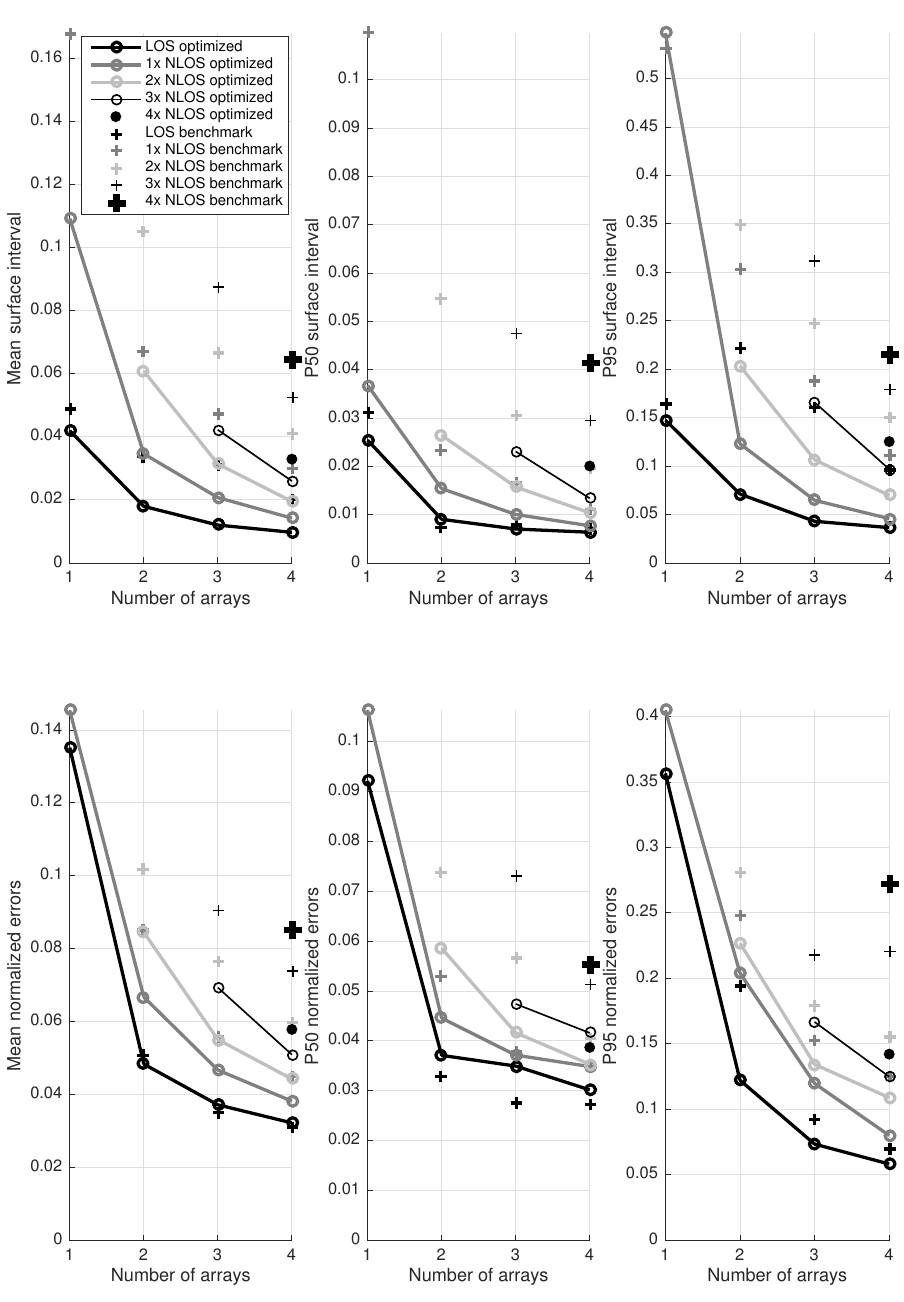
Figure 14. Evaluation of system performance for multiple antenna arrays with all-LOS to all-NLOS